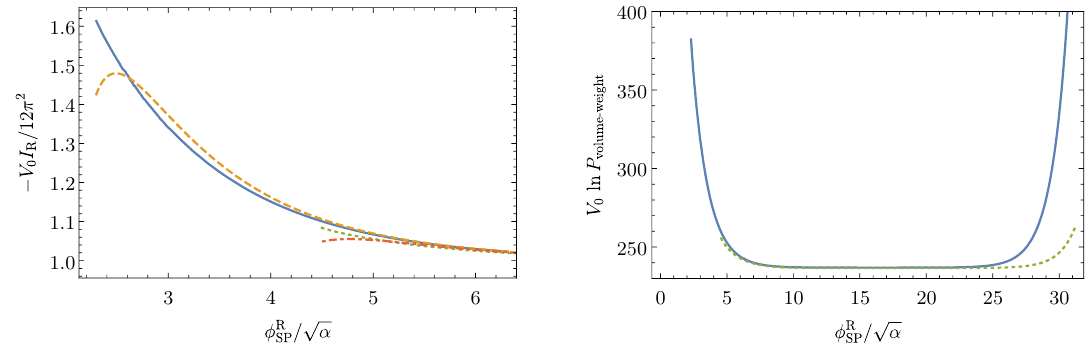
p in units of (cid:11) . The SP